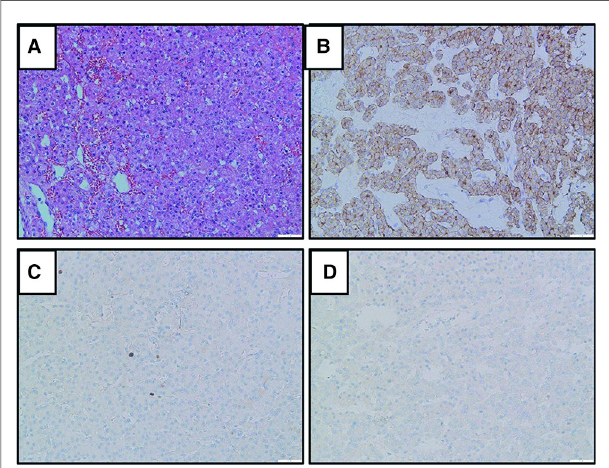
FIGURE 2 | Histology and immunohistochemistry of parathyroid adenoma. ( A ). Hematoxylin and eosin staining. ( B ) Positivity for parathyroid hormone. ( C ) About 2% of positivity for Ki-67 staining. ( D ) Negativity for thyroid transcription factor 1 (TTF-1). Magni fi cation